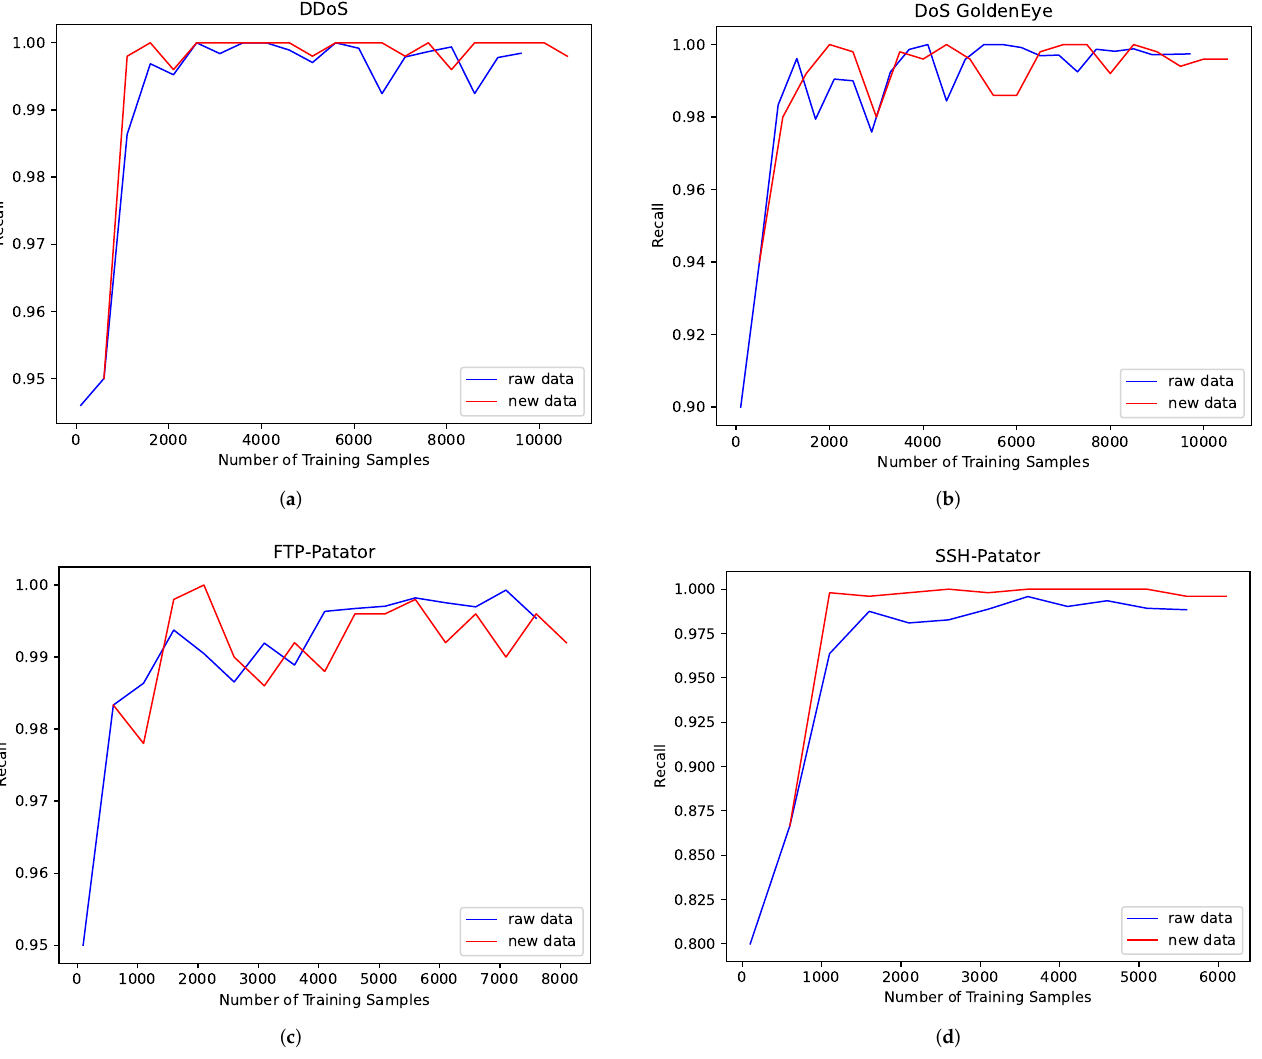
Figure 6. Experimental results of four traffic categories with sufficient sample sizes in the MLP identification algorithm. ( a ) DDoS; ( b ) DoS GoldenEye; ( c ) FTP-Patator; ( d )